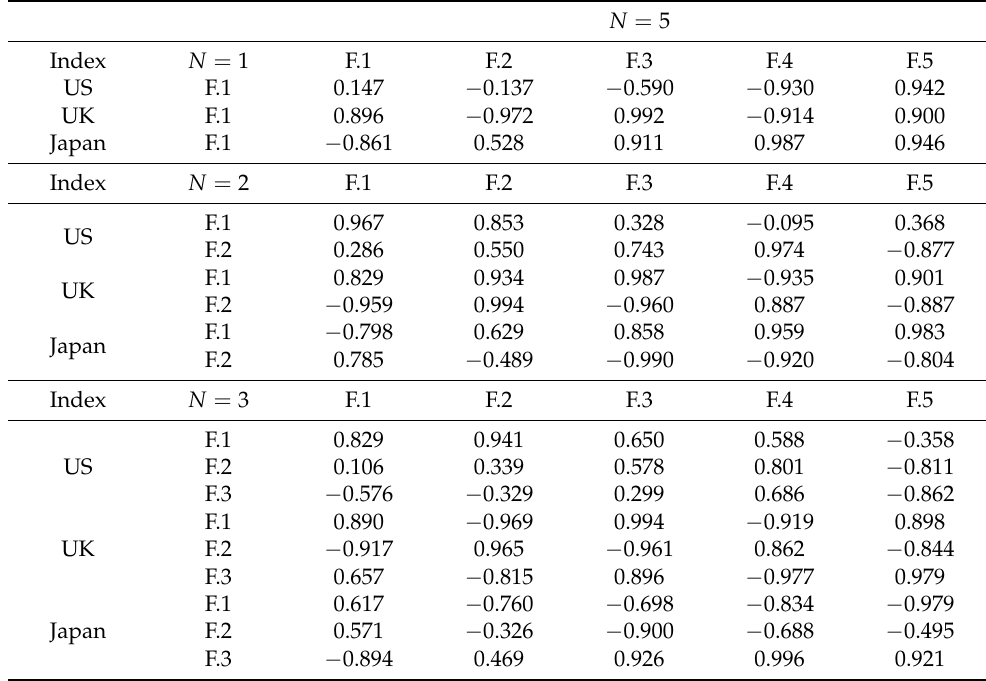
Table 3. Correlation coefficients between the AE results for five features and the AE results for one to three features. Here, N is the number of layers and F.i denotes feature